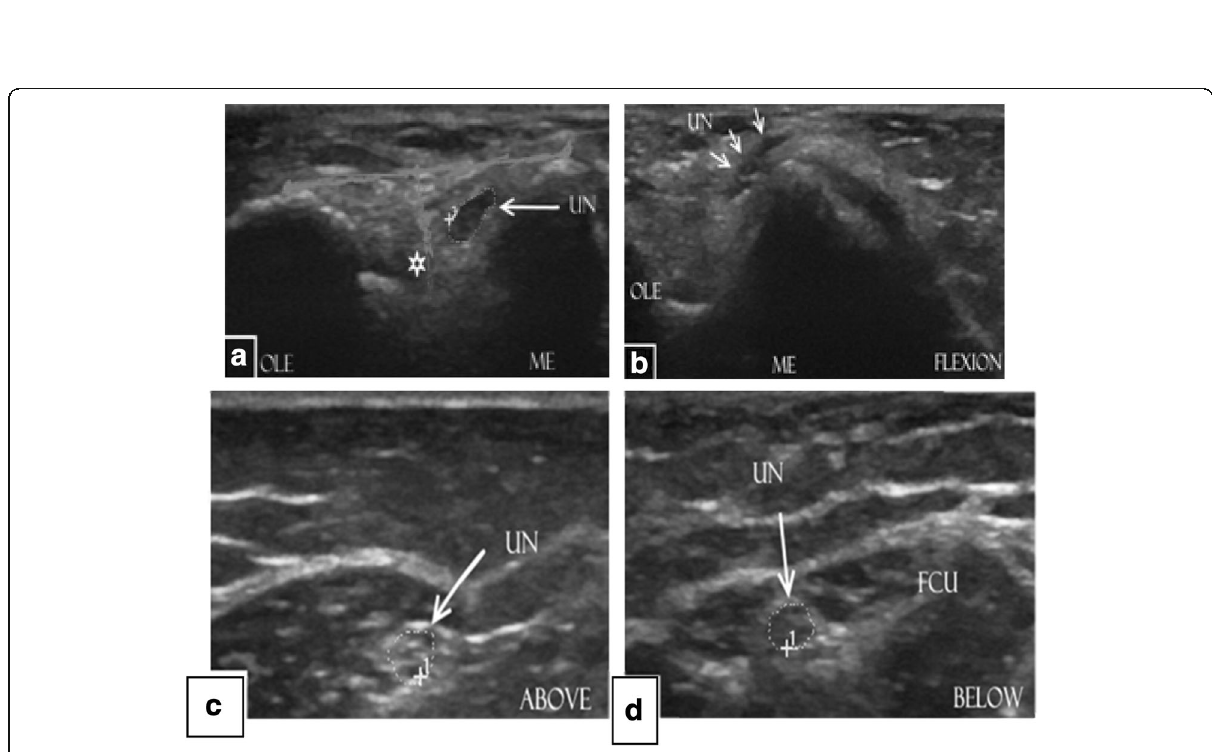
Fig. 5 Dynamic high-resolution ultrasound was done. a Ulnar nerve (white arrows) is seen within the cubital groove during elbow extension, (*) representing the cubital groove floor. b Dislocated ulnar nerve (white arrows) beyond the medial epicondyle during sequential elbow flexion. Average CSA of the ulnar nerve (UN). ME = medial epicondyle. OLE = olecranon process. c Cross-sectional area of the ulnar nerve (UN) above the elbow (white arrow). d Cross-sectional area of the ulnar nerve (UN) below the elbow (white arrow). FCU = flexor carpi ulnaris